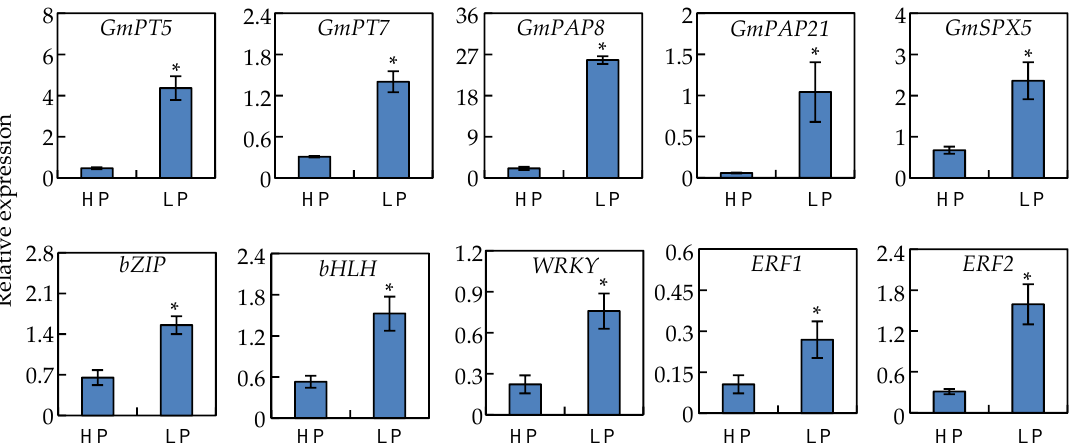
Figure 6. qRT-PCR analysis of ten Pi responsive genes in soybean nodules under Pi sufficient (HP) and deficient (LP) conditions. Data in the figure are mean of four replicates with standard error. Asterisks indicate significant difference between HP and LP treatments in the Student’s t -test (*: p <0.05).